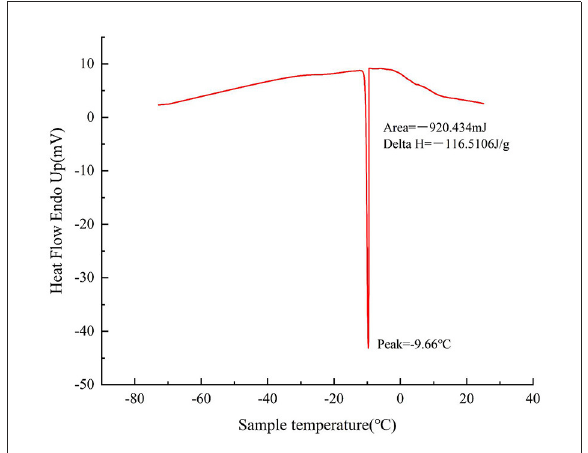
FIGURE1 DSC cooling curve of sample.